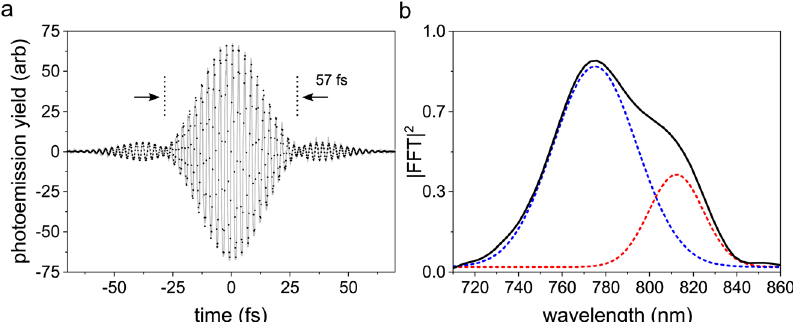
Figure 4: Time and frequency analysis of the multiperiodic array (MPA)-derived wave packet. (a) Autocorrelation trace presented in Figure 3c fi tted to an analytical model of the total fi elds. (b) Frequency domain representation of the time pro